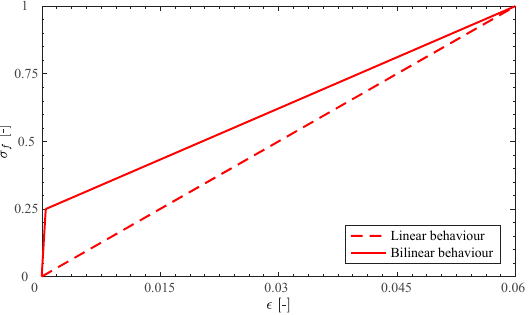
Figure 6. Stress–strain constitutive relationship of composite in tension, adopted for the analyses.